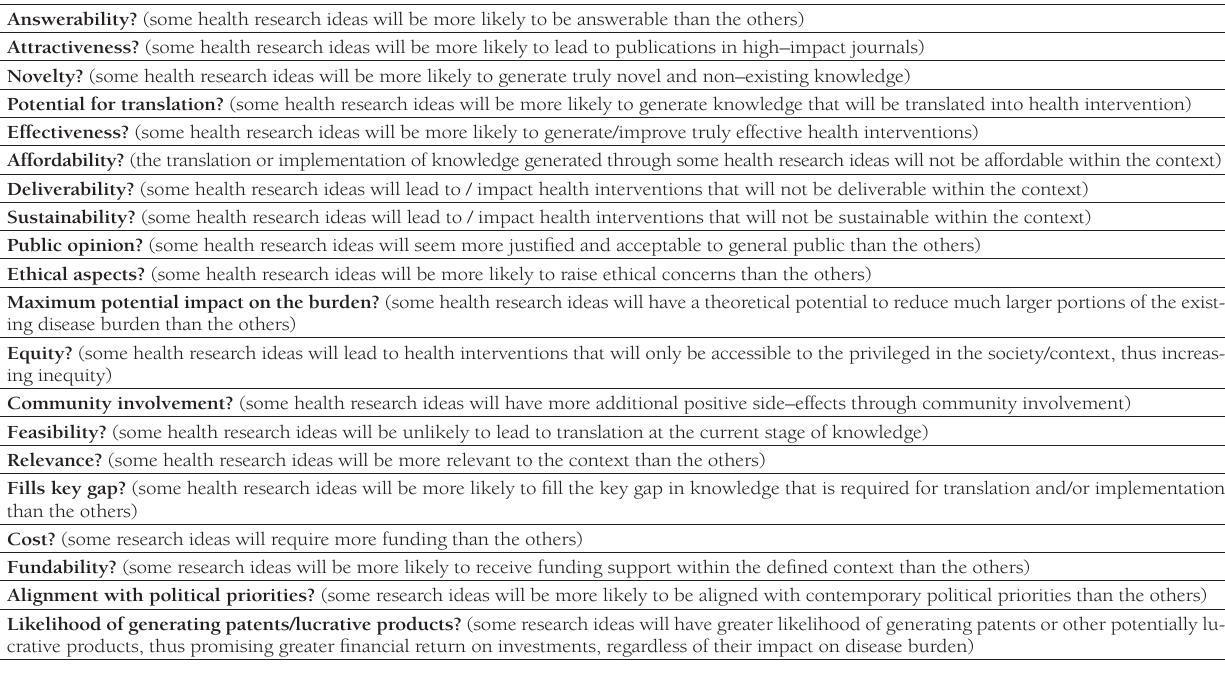
Table 4. Some of the possible priority–setting criteria (and related questions) proposed by Child Health and Nutrition Research Initiative (CHNRI) that can be used to discriminate between any two (or more) health research ideas to set research priorities; the outcomes of the application of different criteria will necessarily conflict each